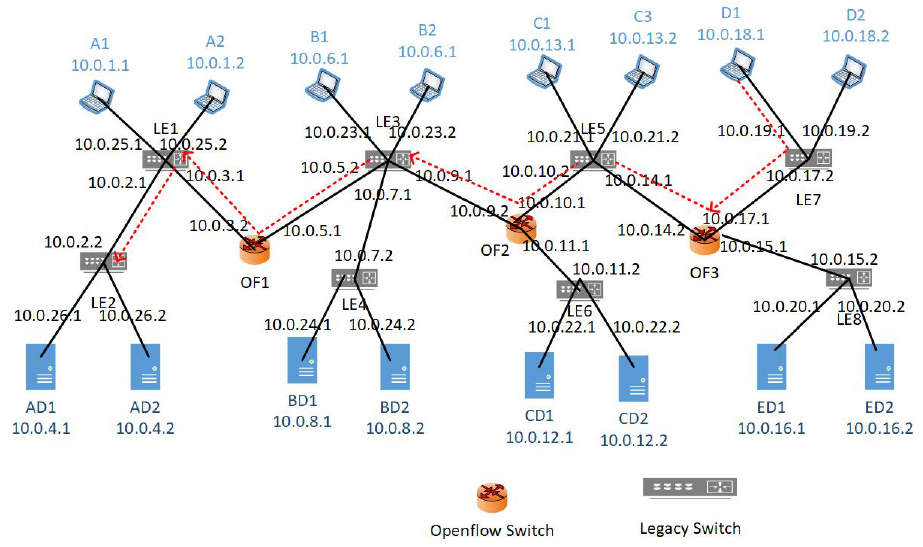
Figure 6. An example Scanrio containing SDN and Legacy switches connected with end